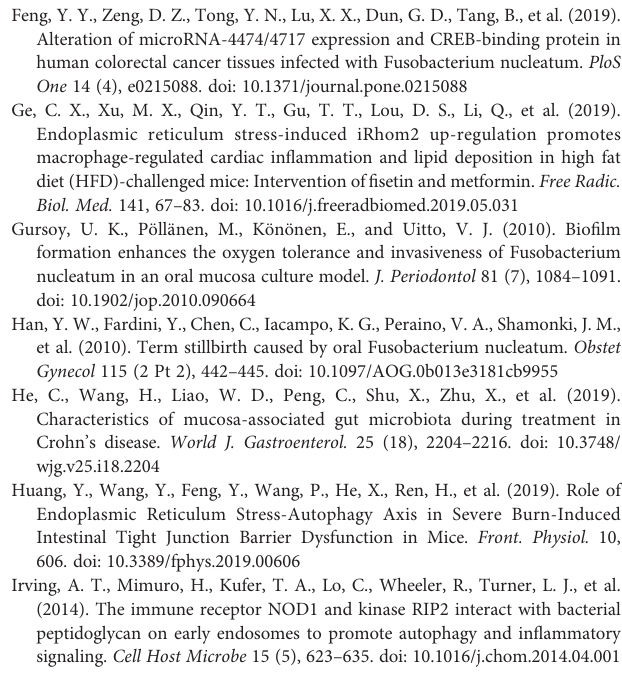
SUPPLEMENTARY FIGURE S1 | F. nucleatum destroys epithelial barrier function in vitro and in vivo (A – H) The protein expression of ZO-1 and Occludin in NCM460 cells (A – D) and FHC cells (E – H) cocultured with F. nucleatum , E. coli or PBS (Control, Con) were quanti fi ed. (I, J) The protein expression of ZO-1 and Occludin expression in mouse tissues were quanti fi ed. (K – N) The protein expression of BIP and XBP1 in NCM460 cells cocultured with F. nucleatum , E. coli or PBS (Control, Con) were quanti fi ed. Data are expressed as mean ± SD for three independent experiments. Statistical signi fi cance is indicated as follows: * P < 0.05, ** P < 0.01, and *** P < 0.001. SUPPLEMENTARY FIGURE S2 | F. nucleatum activates the ER pathway and damages mucosal barrier-associated proteins via ER signaling in vitro and in vivo (A – D) The protein expression of BIP and XBP1 in FHC cells cocultured with F. nucleatum , E. coli or PBS (Control, Con) were quanti fi ed. (E – H) The protein expression of BIP, XBP1, ZO-1 and Occludin in NCM460 cells cocultured with F. nucleatum , 4-PBA or both were quanti fi ed. (I – L) The protein expression of BIP, XBP1, ZO-1 and Occludin in colon tissues from mice were quanti fi ed. Data are expressed as mean ± SD for three independent experiments. Statistical signi fi cance is indicated as follows: * P < 0.05, ** P < 0.01, and *** P < 0.001. SUPPLEMENTARY FIGURE S3 | F. nucleatum activates the ER pathway through the upregulation of CARD3 in vitro and in vivo (A – B) The protein expression of CARD3 in NCM460 cells cocultured with PBS (Control, Con), NC, si001, si002 or si003 were detected by immunoblot and quanti fi ed. (C – E) The protein expression of CARD3, XBP1 and ZO-1 in NCM460 cells transfected with NC, 4-PBA or siCARD3 and infected with F. nucleatum were quanti fi ed. (F – I) The protein expression of CARD3, BIP, XBP1 and ZO-1 in colon tissues from mice were quanti fi ed. Data are expressed as mean ± SD for three independent experiments. Statistical signi fi cance is indicated as follows: * P < 0.05, ** P < 0.01, and *** P <